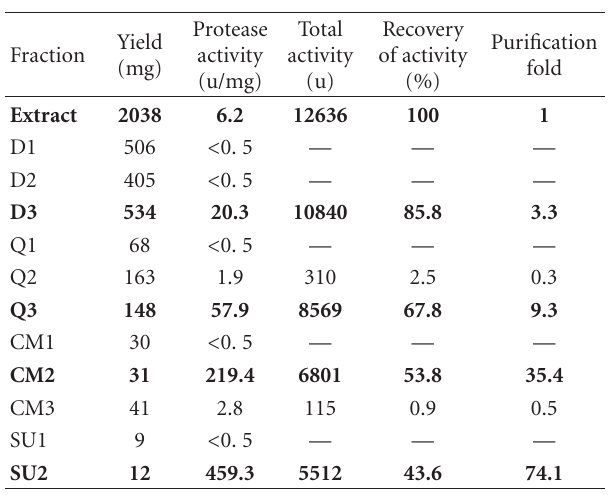
Table 1: Yields and protease activities of various chromatographic fractions of Xylaria hypoxylon (from 500 g fresh fruiting bodies.